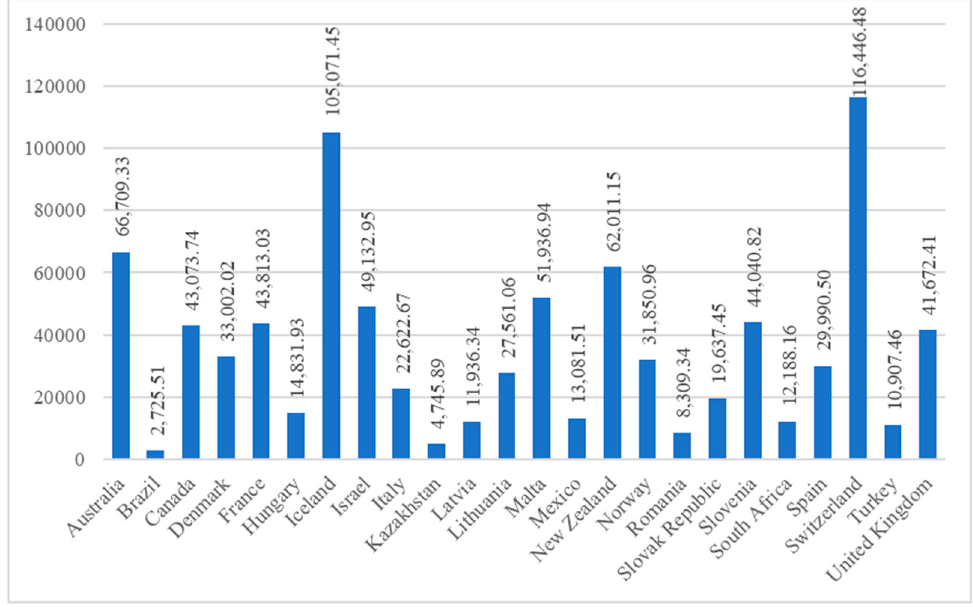
Figure 3. International tourism receipts per worker (USD) in 2017. Countries in alphabetical order. Source: UNWTO and OECD data for 2017.